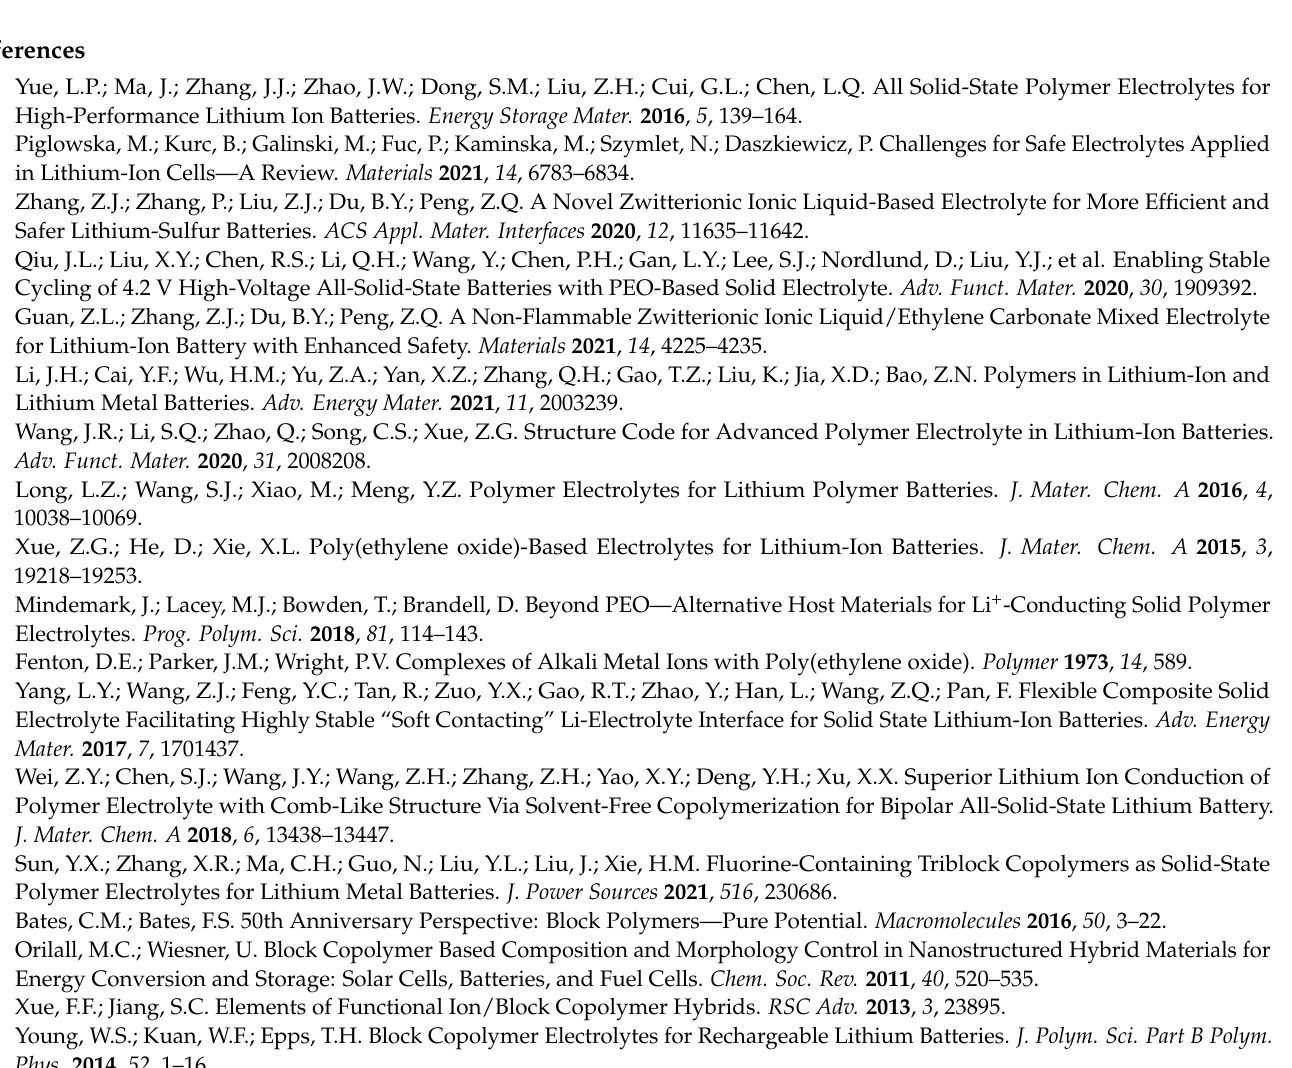
Figures S5 and S6: SAXS profiles; Figure S7: Chronoamperometry and EIS of the Li/PEO 114 - b -PDM 36 - Table S1: Molecular characteristics of PEO 114 - b -PDM n ; Table S2: Densities of PEO/LiTFSI and PDM- dTFSI/LiTFSI hybrids; Table S3: Vogel-Tammann-Fulcher (VTF) equation fitting results; Ref. [61] can be found in Supplementary